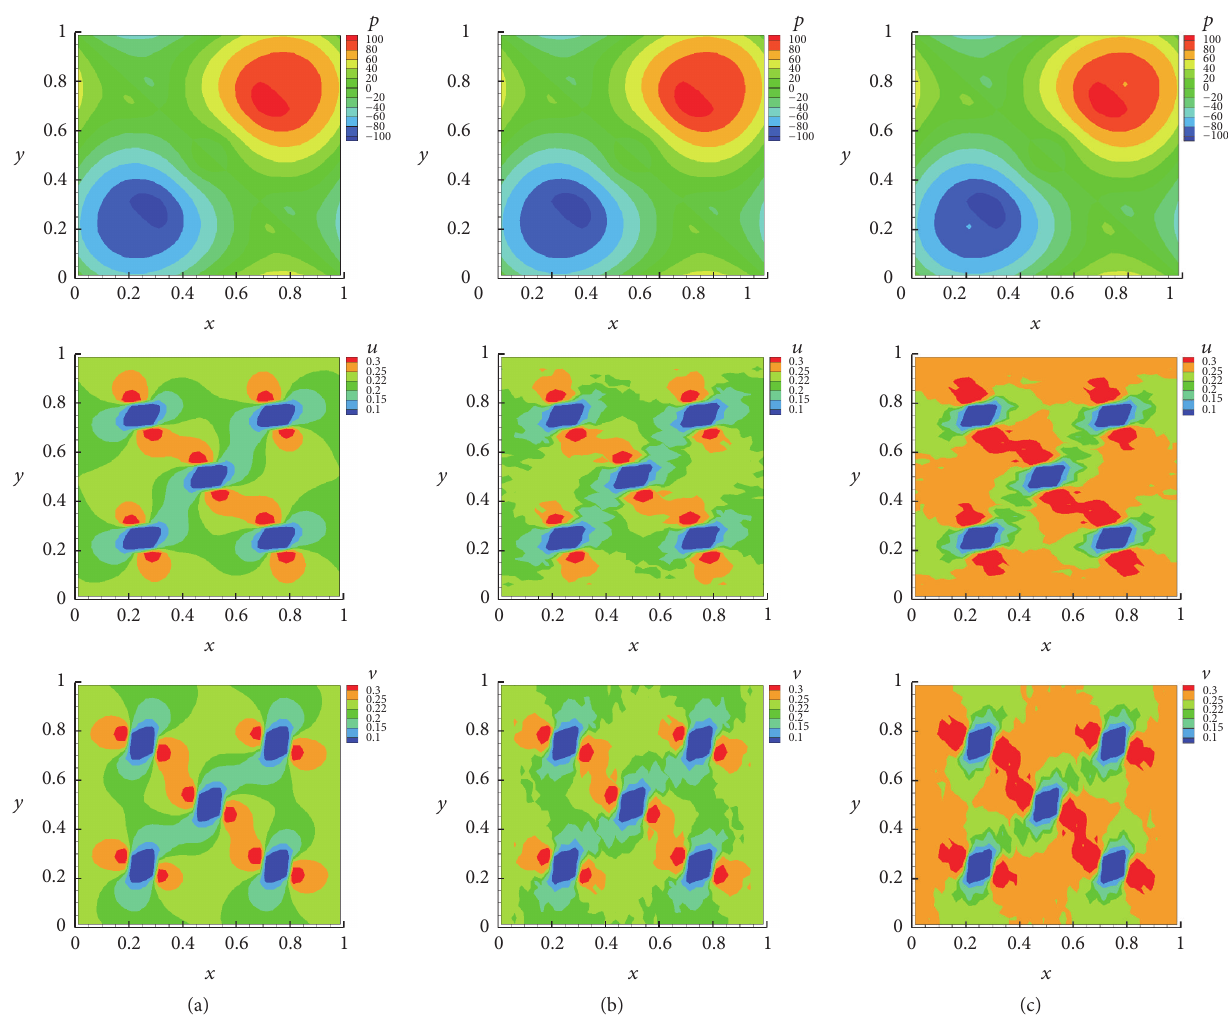
Figure 8: Comparisons of 𝑝 , 𝑢 , and V between the fine-grid averaged results (a) and coarse-grid results using 𝜅 ∗ (𝜅, ] eff ) (b) and 𝜅 ∗, err (𝜅) (c), = 10 −5 m 2 s −1 , ⃗𝐺 = ( sin 𝜋𝑥, sin 𝜋𝑦) ms −2 , and 𝜅 ] eff